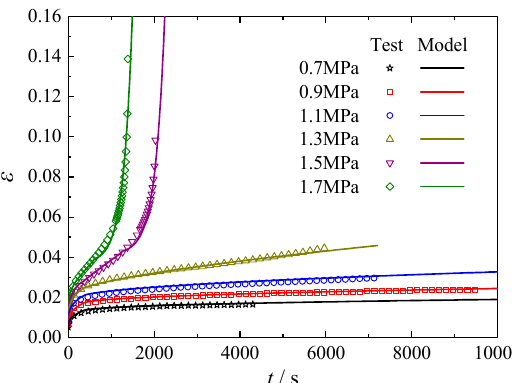
Figure 11. Creep of asphalt mixture: model vs. test.